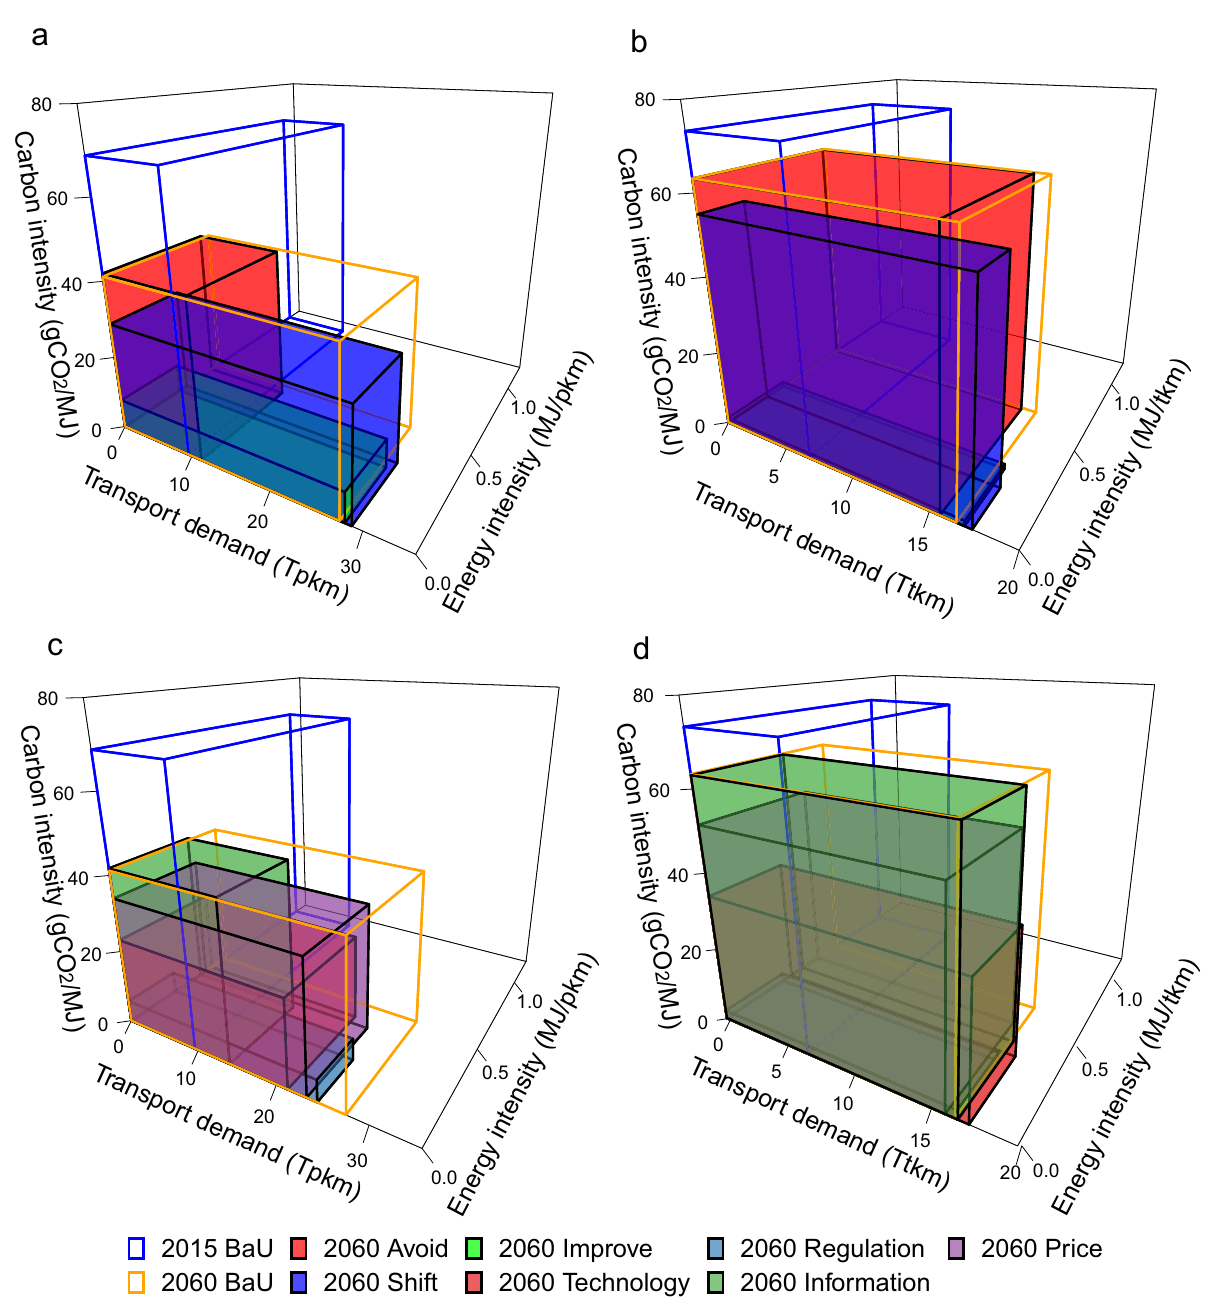
Fig. 4 CO 2 emissions, transport demand, energy intensity, and carbon intensity in 2015 and 2060 under different strategies and instruments. a Passenger transport under BaU and three strategies. b Freight transport under BaU and three strategies. c Passenger transport under BaU and four instruments. d Freight transport under BaU and four